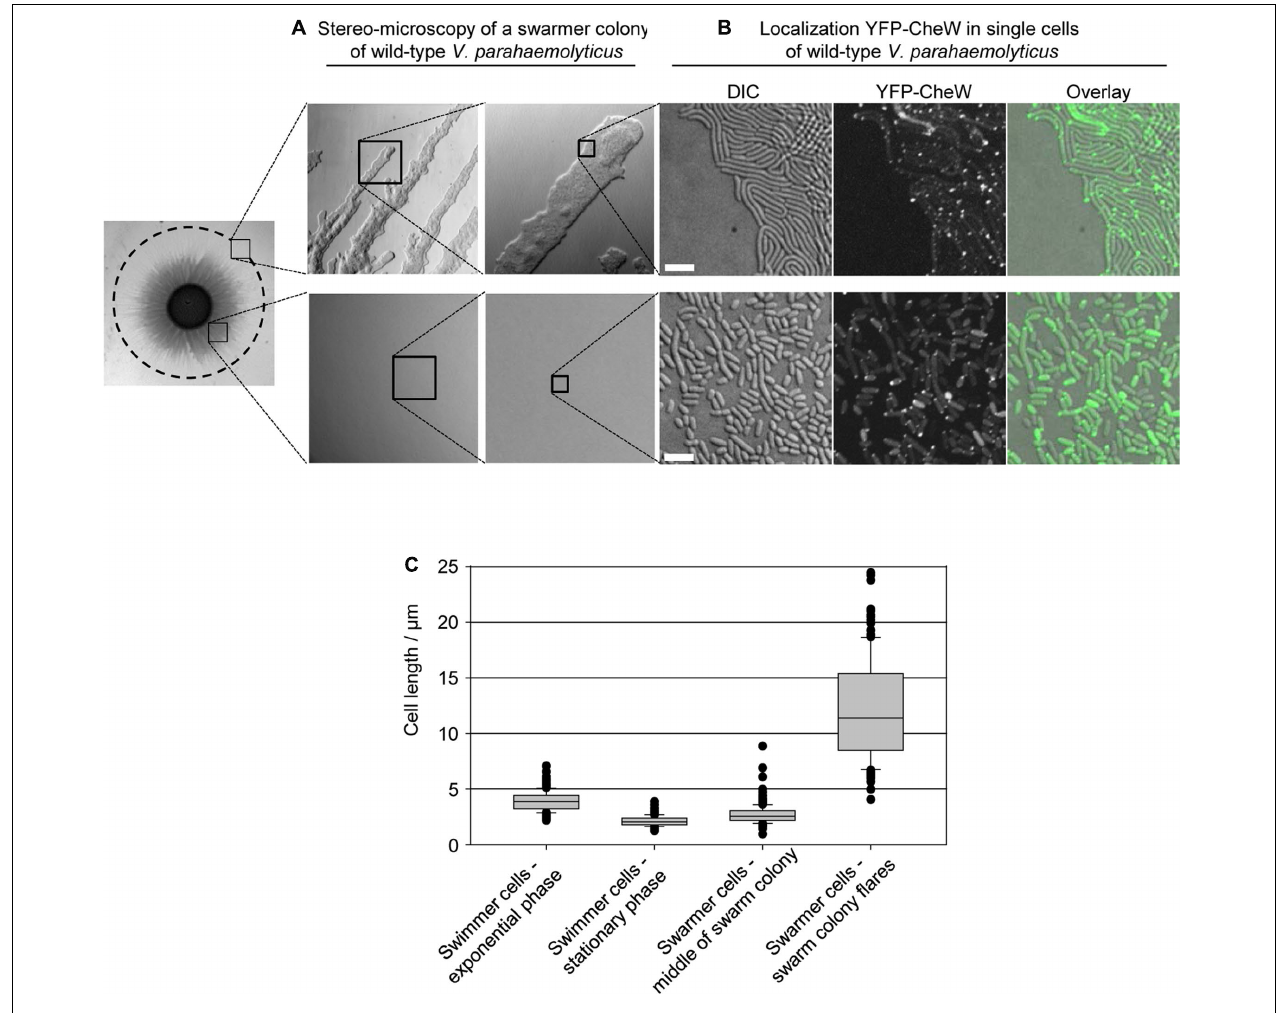
FIGURE 7 | Localization of signaling arrays in swarmer cells changes with swarm-colony development. (A) Stereo-microscopy of a swarmer colony of V. parahaemolyticus . Upper panel shows the swarm flares at higher magnifications, and lower panel shows the middle of a swarm colony at higher magnifications. (B) Fluorescence microscopy showing the localization of YFP-CheW in V. parahaemolyticus cells from the periphery (swarm flares) and middle of swarm colonies. Images are representative of areas indicated in (A) . Cells from the periphery were imprinted on microscope slides. Due to cells being stacked in multilayers, cells from the middle were scraped off plates, re-suspended in medium and spotted on a microscope slide, in order to obtain single layered cells for microscopy. (C) Graph showing the cell-length distribution of V. parahaemolyticus depending on its growth phase and position within swarm colonies; swimmer cells – exponential phase, n = 297; swimmer cells stationary phase, n = 300; swarmer cell – middle, n = 307; swarmer cells – periphery, n =